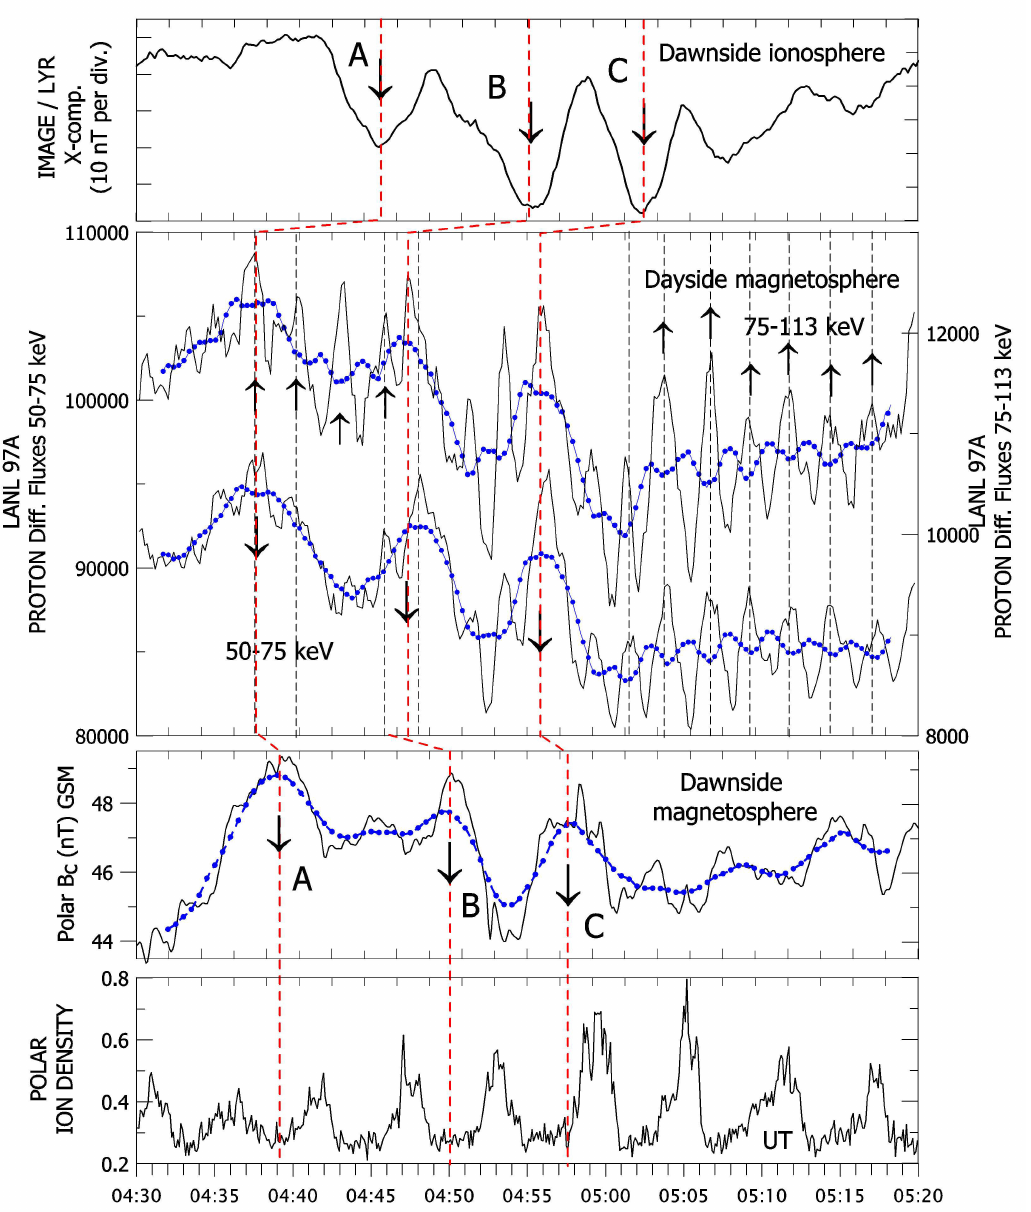
Fig. 6. From top to bottom: X-component magnetogram from the ground station LYR; differential fluxes from the two energetic proton LANL 97A channels (50–75 and 75–113keV, thin lines); and compressional magnetic field component and ion density from the POLAR satellite. The dotted-thick lines represent low-pass filtered data, while the capital letters A, B and C mark the occurrence times for the three solar wind pressure pulses, which, in turn, modulate the 97 A fluxes and the POLAR total magnetic field trace. The 97A fluxes are clearly modulated by a wave of period T ∼=